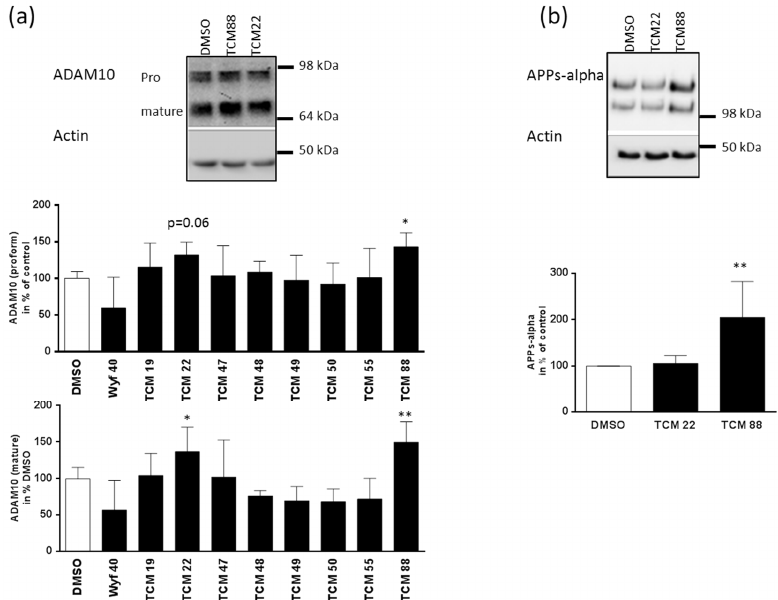
Figure 3. Influence of candidate substances on ADAM10 expression and APPs-alpha secretion. ( a ) Expression of ADAM10. Cells were incubated for 48 h with substances according to results from toxicity assay in FCS-containing medium (see Figure 1). DMSO (solvent) served as control. Twenty percent of cell lysates were subjected to Western blotting and ADAM10 was detected with Calbiochem antibody (dilution 1:1000). Actin served as a loading control (antibody (Sigma-Aldrich, Darmstadt, Germany) diluted 1:1000). Pro- and mature forms of the enzyme were measured, normalized to Actin and depicted in % of DMSO control-treated cells. Values ± SD were collected from three independent experiments. An exemplary blot for analysis of DMSO, TCM22 and 88 is shown. ( b ) Effect of TCM22 and 88 on APP processing. For secretion experiments, cells were incubated for the last 5 h in FCS-free medium supplemented with the candidate substances. The whole amount of precipitated proteins from cell supernatant was used for detection of APPs-alpha (antibody 6E10 (BioLegend, Fell, Germany)) and 20% of the cell lysate for detection of Actin to ascertain comparable amounts of cells in the experimental setting. Values obtained for APPs-alpha were normalized to Actin measurements and presented in % of solvent control ( n = 6, four independent experiments). Statistical analysis: one-way ANOVA; **, p < 0.01; *, p <